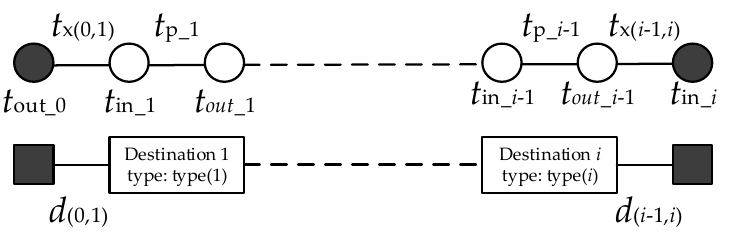
Figure A1. Schematic diagram of trip chain.